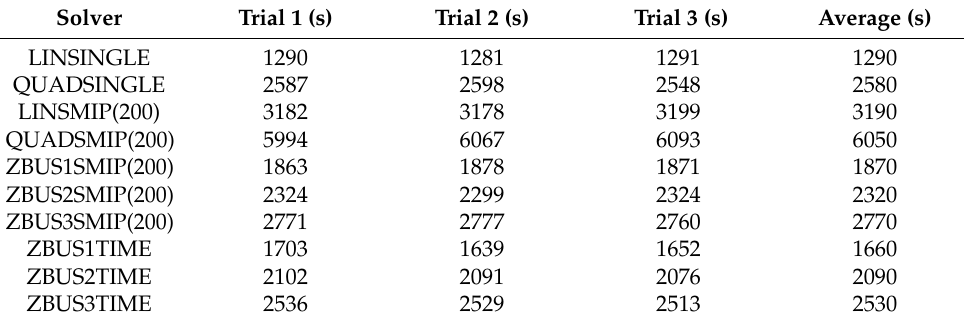
Table 3. Solve time for each power flow method averaged across three trials, P ∆ = 200